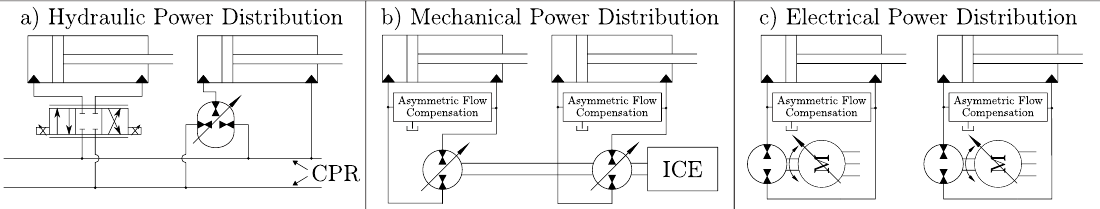
Figure 1. Three different power distribution topologies. In ( a ) power is distributed hydraulically by common pressure rails (CPR) to a control element controlling each actuator. In ( b ) power is distributed mechanically by a rotating shaft to multiple rotating hydraulic pumps, each controlling the motion of a cylinder. The shaft may be driven by an internal combustion engine (ICE). In ( c ) power is electrically distributed, requiring both an electric machine and a hydraulic pump for controlling each